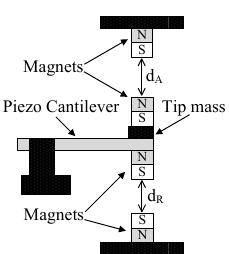
Figure 7. Schematic representation of the magnetic forces based MTT proposed in [7].